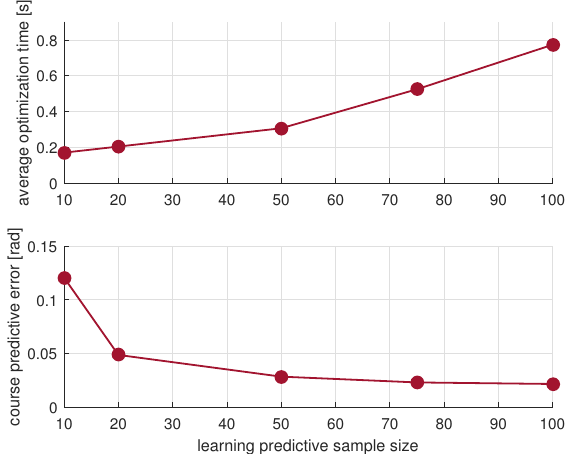
Figure 11. The effect of learning sample size in Gaussian model on prediction accuracy and optimiza- tion